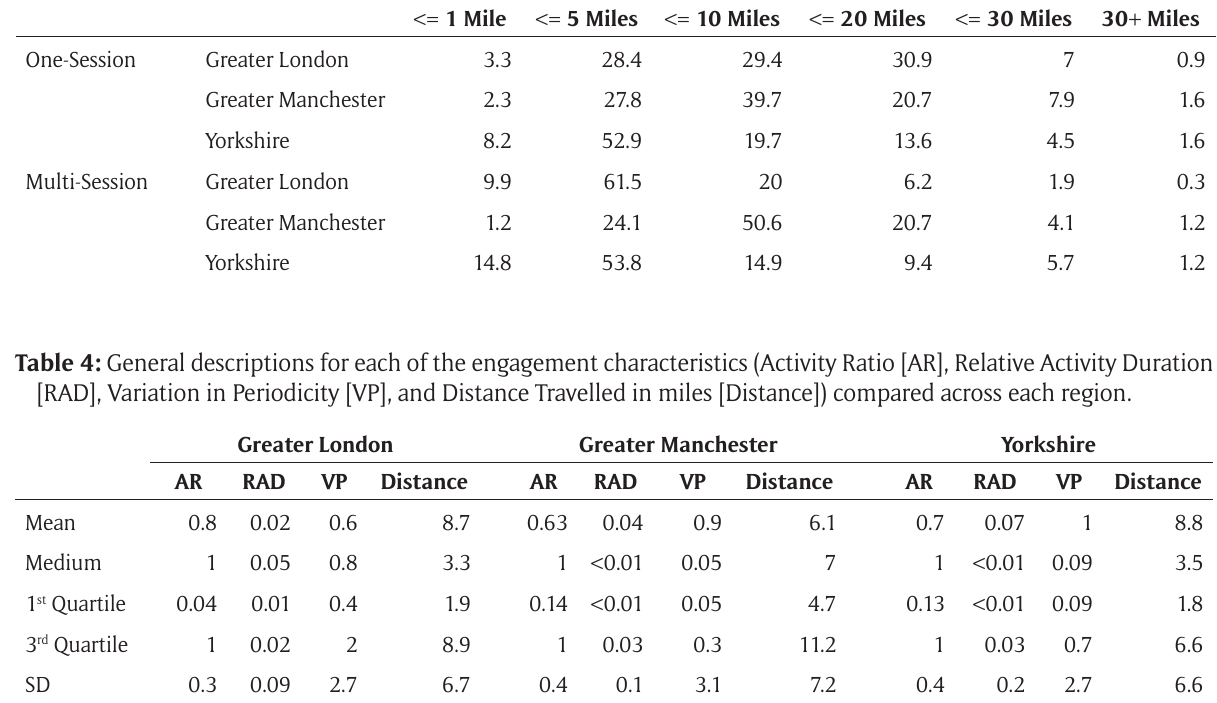
Table 3: Volunteer travelling distances in percentage across the three geographical regions for each volunteer type. Volunteer Type